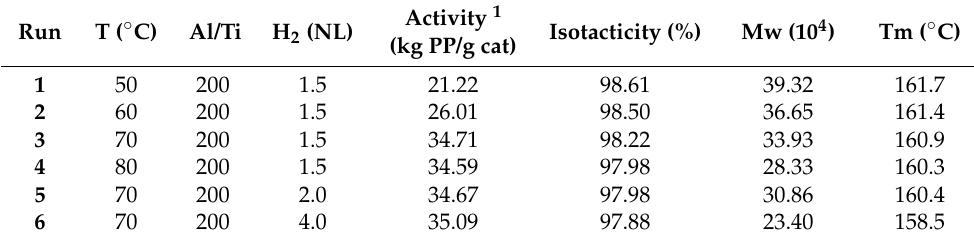
Table 2. Results of the bulk polymerization of propylene 1